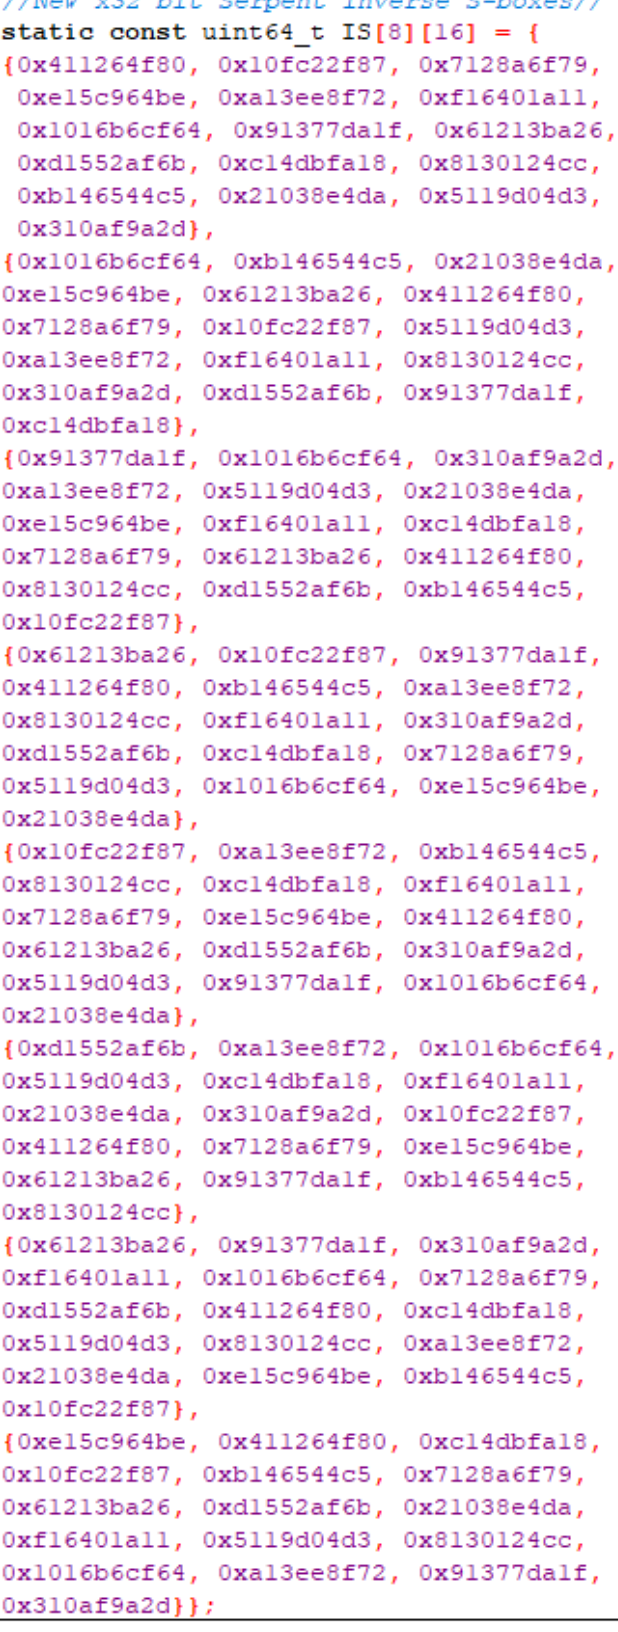
Figure 6. New inverse of 32-bit S-Boxes written in